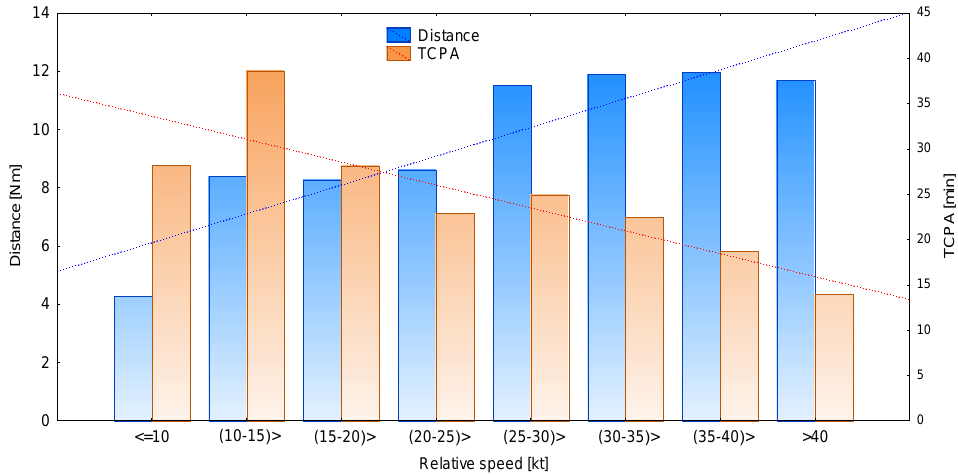
Figure 3. Relation between relative speed, TCPA and the distance between ships at the start of the manoeuvre.